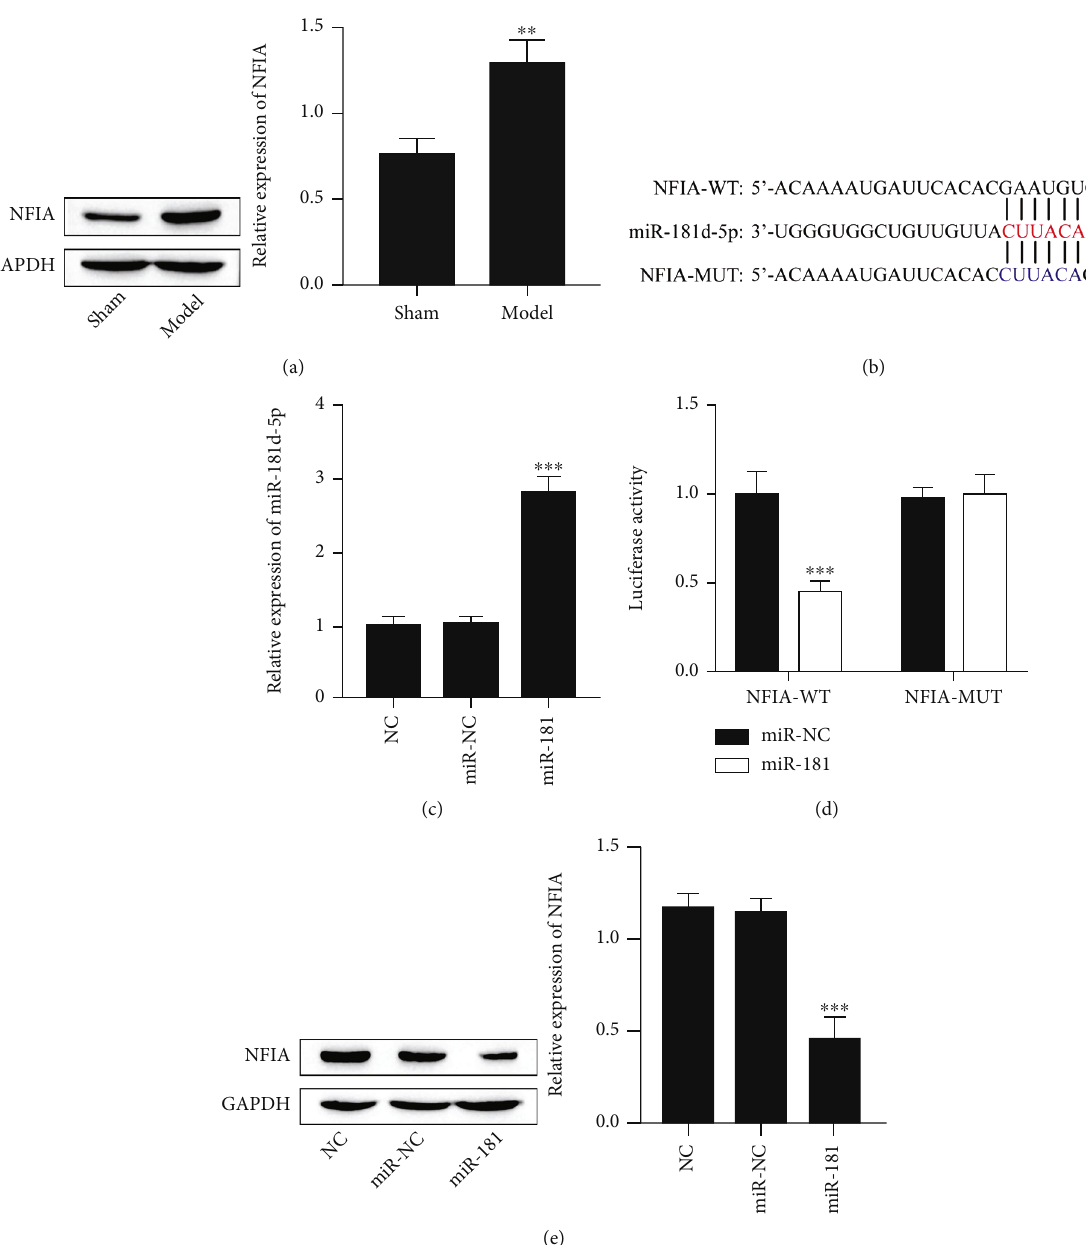
Figure 4: miR-181d-5p directly targeted the NFIA gene. (a) Representative western blot of nuclear factor I-A (NFIA). ∗∗ P < 0 : 01 vs. the sham group. (b) The binding sites of miR-181d-5p in the NFIA sequence by starBase prediction. (c) Expression of miR-181d-5p by RT- qPCR detection. ∗∗∗ P < 0 : 001 . (d) The interaction between the NFIA 3 ′ UTR and miR-181d-5p was analyzed by a dual-luciferase reporter gene. 293T cells were cotransfected with miR-181d-5p mimic and WT-NFIA or miR-181d-5p mimic and MUT-NFIA. ∗∗∗ P < 0 : 001 . (e) Representative western blot of NFIA. ∗∗∗ P < 0 : 001